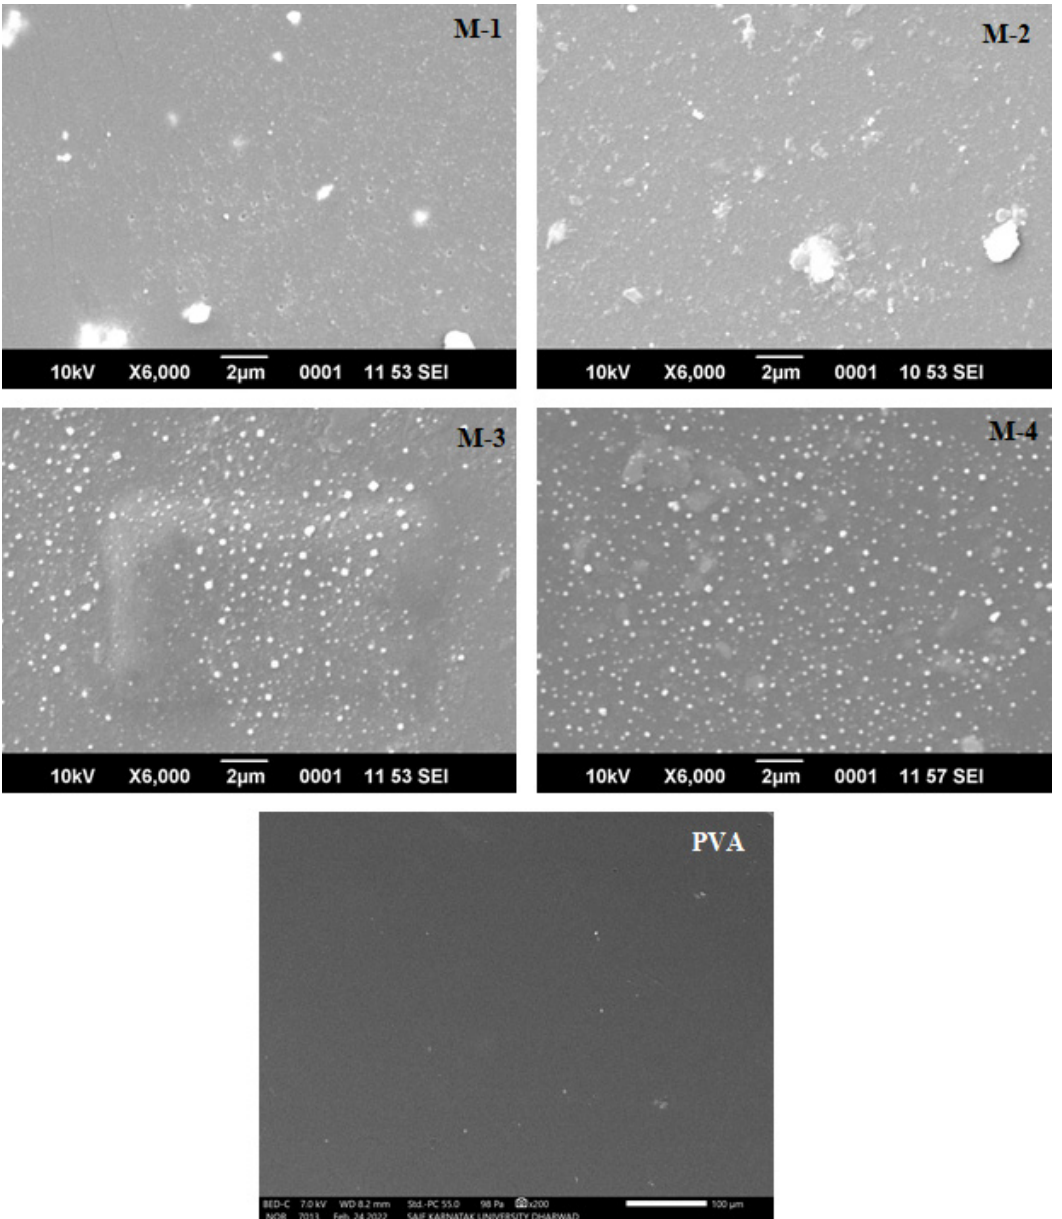
Figure 5. SEM micrographs of PVA and CS-capped AgNP-incorporated PVA hybrid membranes: (M-1) 0.5 wt.%; (M-2) 1 wt.%; (M-3) 1.5 wt.%; (M-4) 2 wt.% of CS-capped AgNPs.